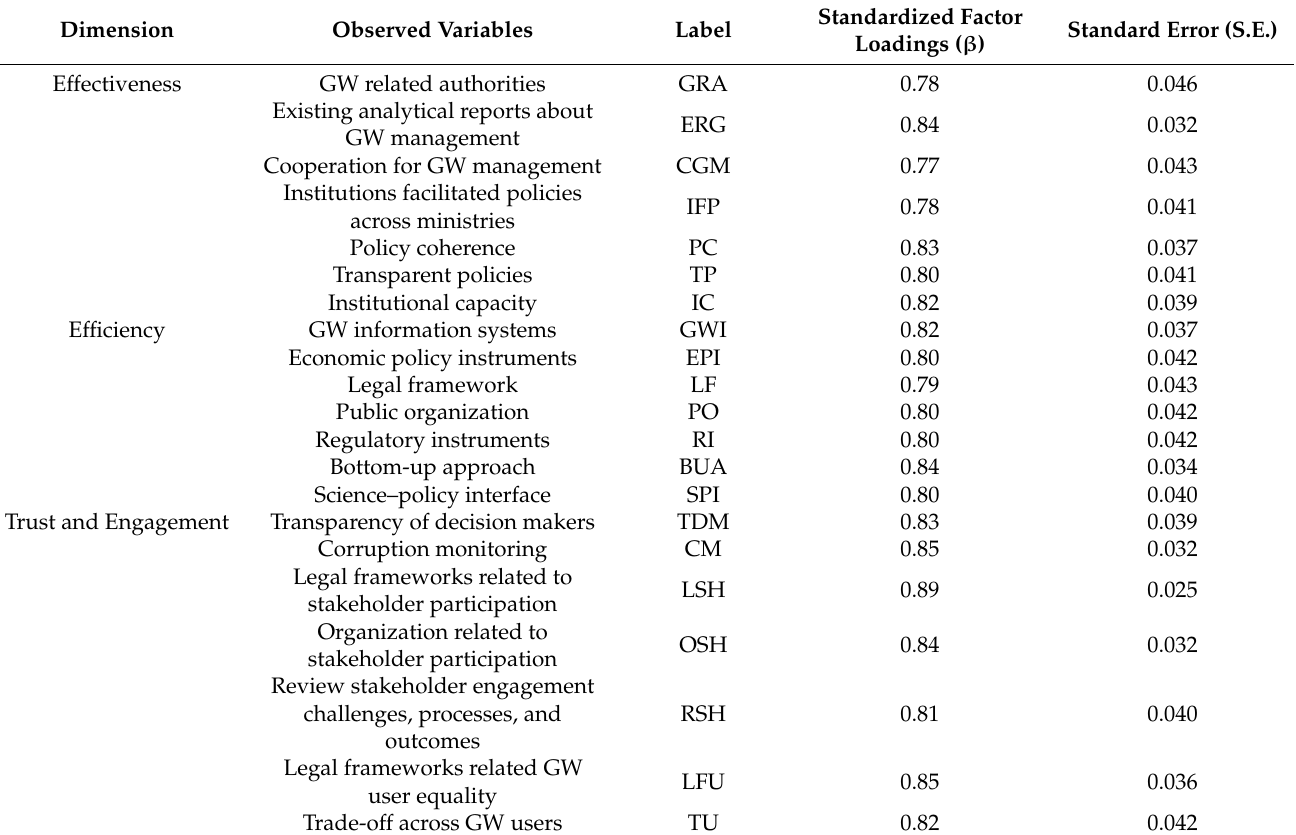
Table 1. Standardized factor loadings ( β ) and standard error (S.E.) of GWG